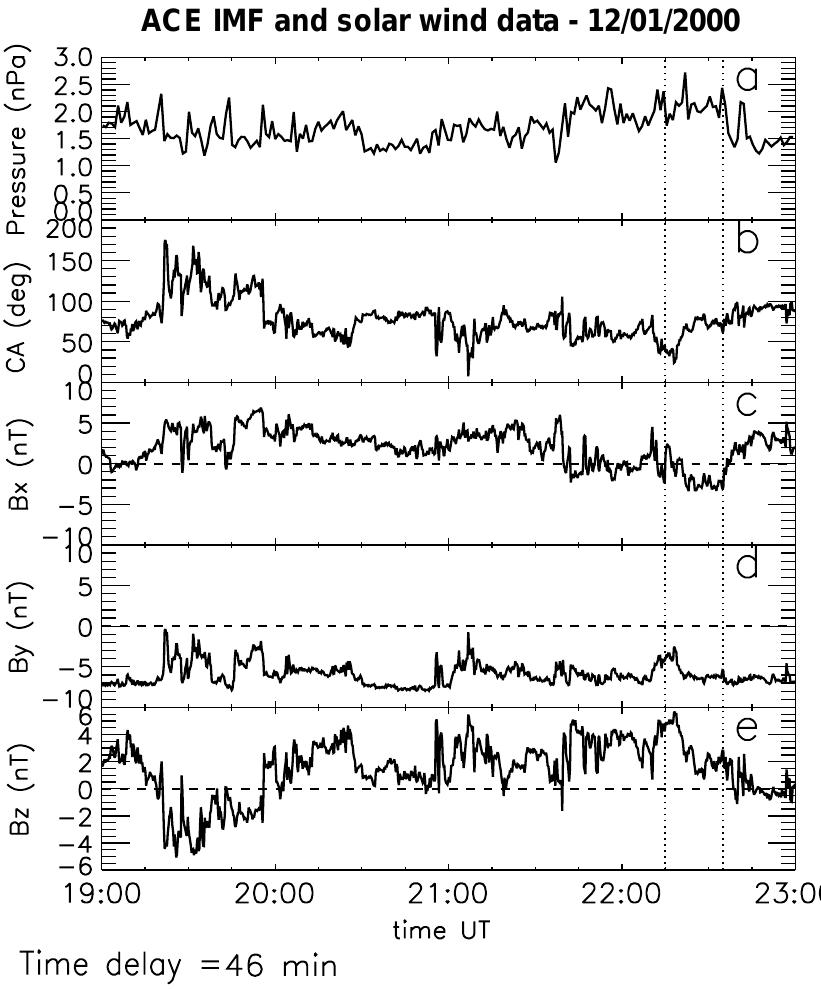
Fig. 2. Interplanetary magnetic field (IMF) and solar wind plasma data from the ACE spacecraft on 12 January 2000. Data are lagged by 46min, to take into account the delay from the spacecraft to the ionosphere. (a) Solar wind pres- sure. (b) IMF clock angle. Panels (c) , (d) and (e) show ,respectively, the IMF B x , B y and B z components in GSM co-